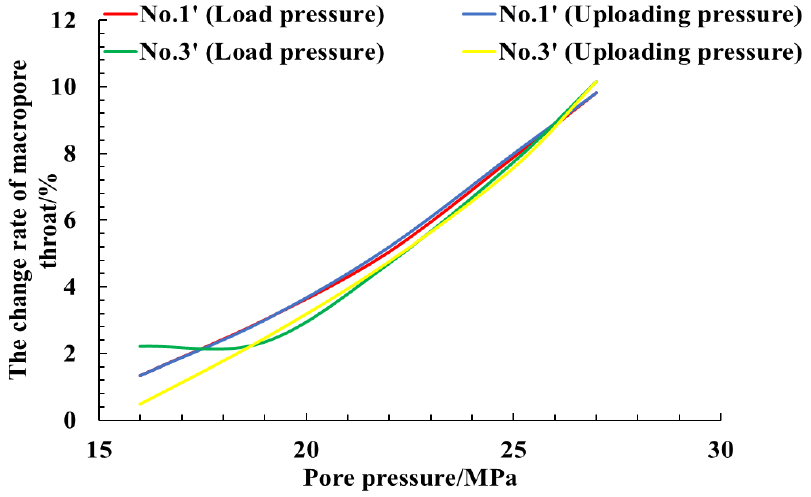
Figure 7. The change rate of macropore throats with different pore pressures of fractured samples.